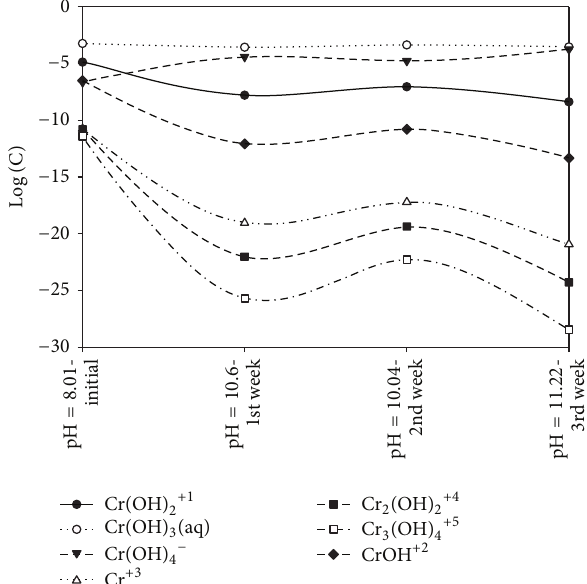
Figure 12: Speciation diagram for trivalent Cr species at different weekly pH